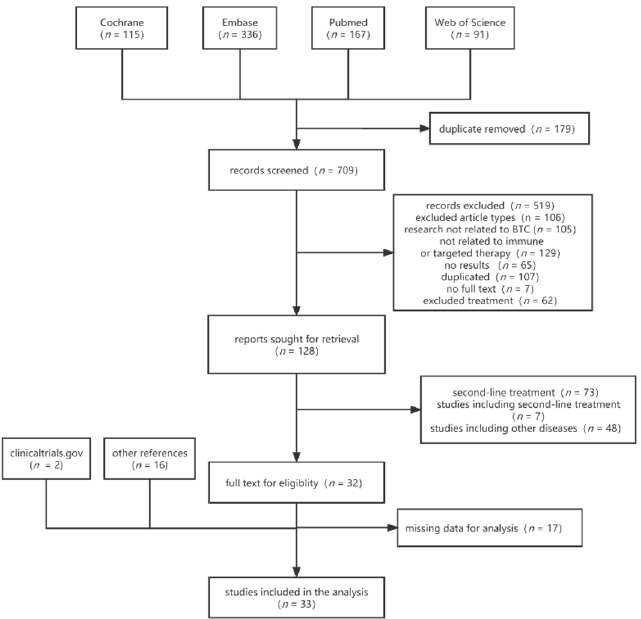
Figure 1. Flowchart of study selection.